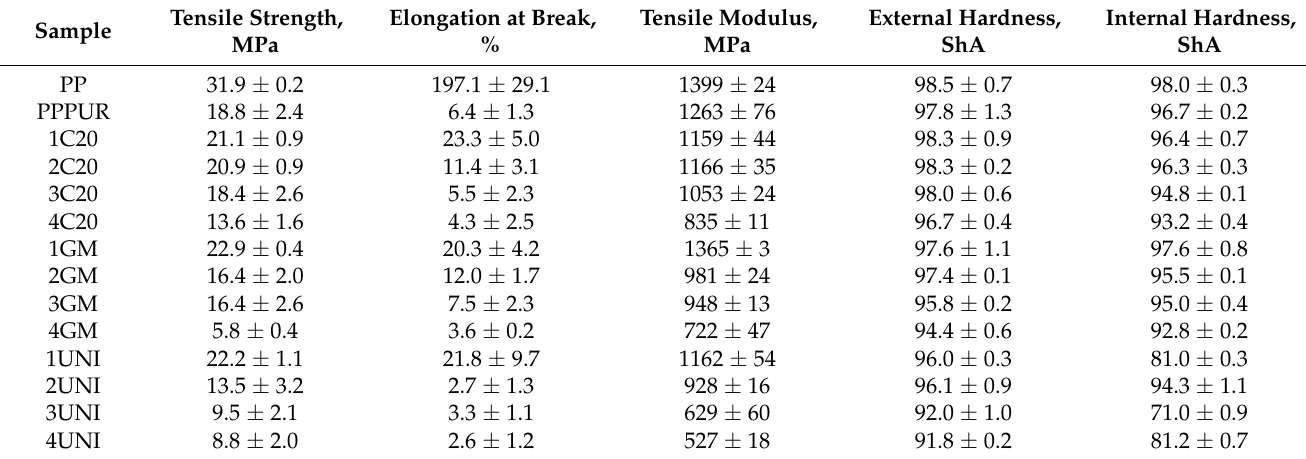
Table 2. The results of static mechanical tests performed on the prepared